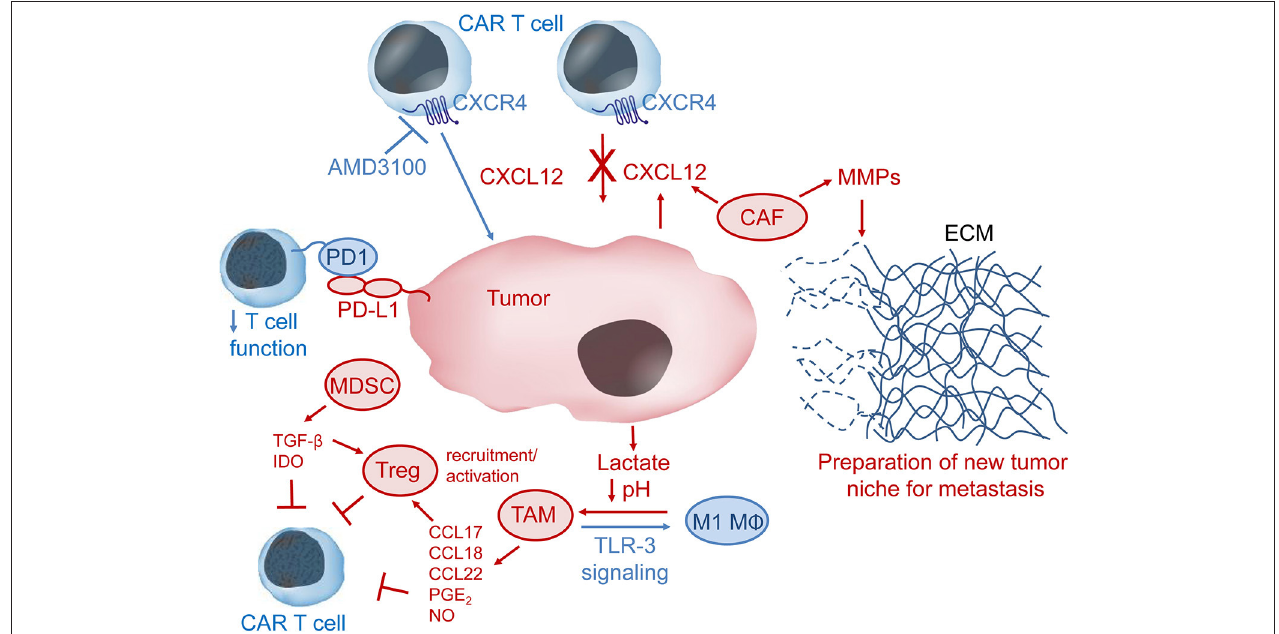
FIGURE 3 | The immunosuppressive tumor microenvironment (TME). CXCL12 in the TME may recruit CXCR4-expressing immunosuppressive cells such as tumor-associated macrophages (TAM), myeloid-derived suppressor cells (MDSC), cancer-associated fibroblasts (CAF), and regulatory T cells (Treg) to the tumor niche. CAF can secrete metallomatrix proteins (MMPs) that lead to remodeling of the extracellular matrix (ECM) via degradation of ECM proteins such as collagen, elastin, fibronectin and laminin. ECM remodeling may be important for tumor invasion and metastasis. Lactate produced by tumor cells leads to lower pH in the TME and can facilitate polarization of M1 macrophages (M 8 ) to immunosuppressive TAM, which produce several chemokines and other factors, such as prostaglandin E2 (PGE 2 ) and nitric oxide (NO), that inhibit CAR-T cells either directly or via activation of Treg cells. Stimulation of toll-like receptor 3 (TLR-3) signaling may convert TAM to pro-inflammatory M1 M 8 . MDSC produce and secrete the immunomodulatory factors transforming growth factor β (TGF- β ) and indoleamine 2,3-dioxygenase (IDO), which inhibit CAR-T cell anti-tumor activity. Immune checkpoint inhibition, e.g., via interaction of programmed cell death 1 (PD1) on T cells with programmed cell death ligand 1 (PD-L1) on tumor or tumor-associated cells, results in down-regulation of T cell activity. Pharmacologic inhibition of the CXCL12 receptor CXCR4 might help CAR-T cells overcome the CXCL12 tumor barrier and thus increase CAR-T cell anti-tumor